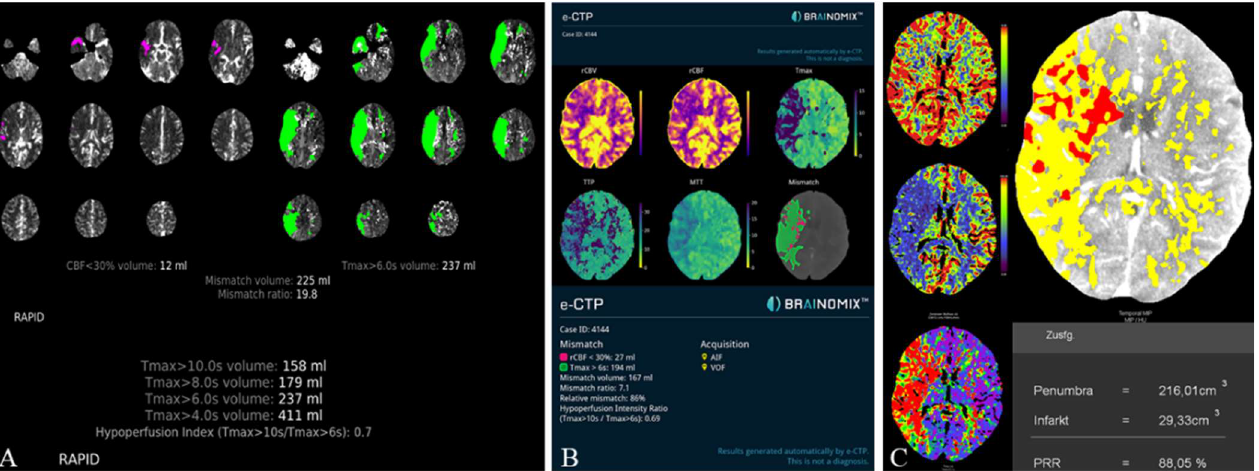
Figure 3. Illustrative Perfusion results of a patient with M1-occlusion of the right hemisphere (RAPID ( A ), Brainomix ( B ), and Syngo ( C )). Packages A and B provide automated calculation of the HIR, which can be directly read from the perfusion maps. For Syngo, the HIR was calculated with a result of 0.7.